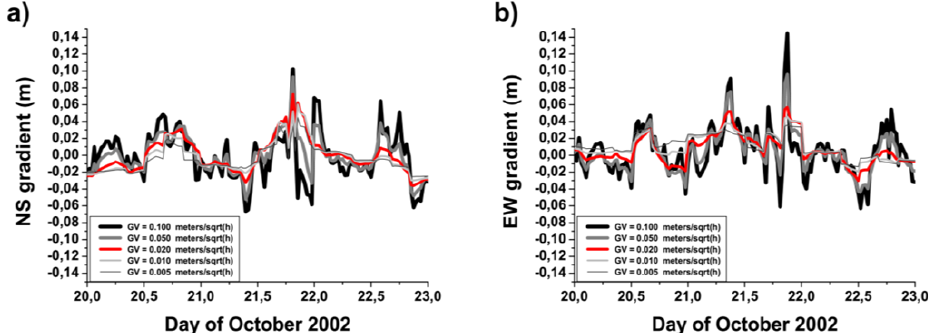
Fig. 7. Time series of horizontal gradient evaluations (GRAD) at BORD for the period from 20–22 October 2002: (a) North–South com- ponent; (b) East–West component. Tests of the gradient variation (GV) with values of 0.1mh − 1 / 2 , 0.05mh − 1 / 2 , 0.02mh − 1 / 2 (reference), 0.01mh − 1 / 2 and 0.005mh − 1 / 2 are presented.